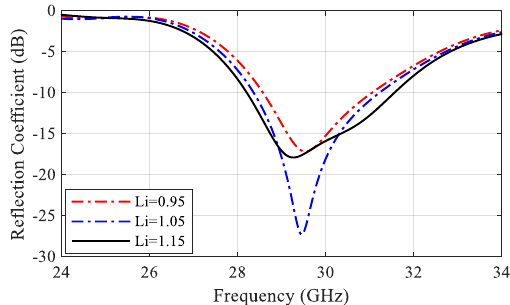
Figure 5. Effect of the CPW length 𝐿 i on the antenna array reflection coefficient.